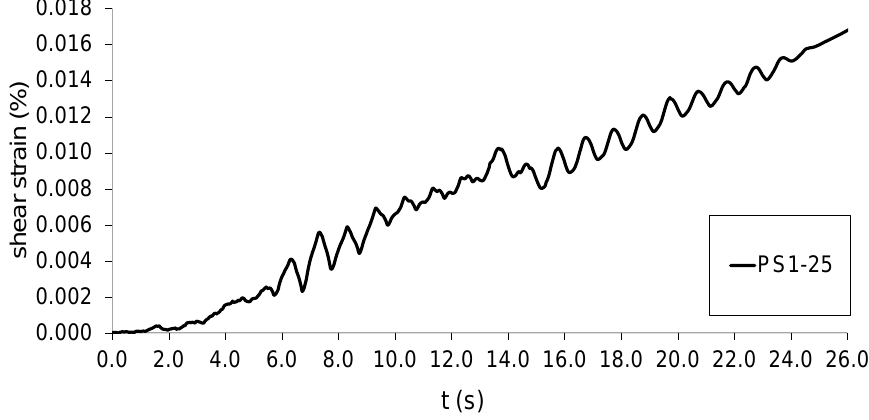
Figure 7. Shear strain time history (PS1-25) at −5 m depth.